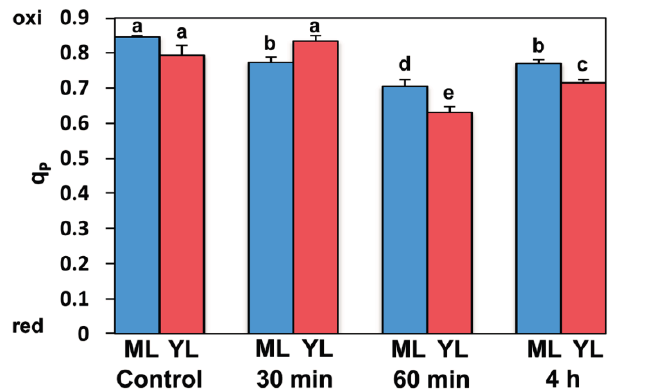
Figure 3. Changes of photochemical quenching ( q ), the fraction of open PSII reaction P centers, of control and after 30 min, 60 min, and 4 h Pq exposure of A. thaliana mature (ML) and young leaves (YL). Blue columns: mature leaves; red columns: young leaves. Data shown are means ± SE that is indicated by bars ( n = 6). Columns with different lowercase letters are significantly different ( p <